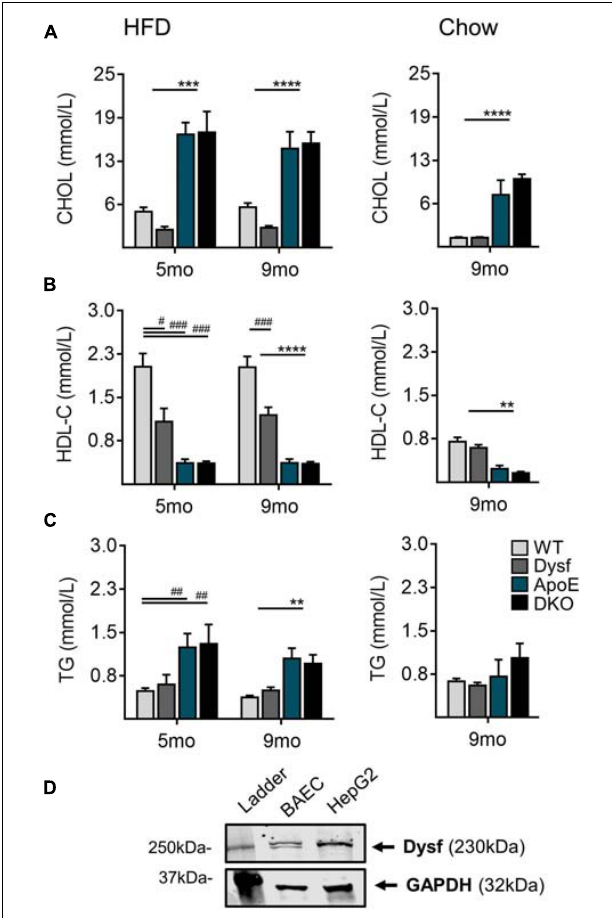
FIGURE 3 | Total plasma cholesterol, high density lipoprotein cholesterol and triglyceride levels in WT, Dysf, ApoE and DKO mice after 5 and 9 months (mo) of HFD-feeding and age-matched chow controls at 9 months. (A) Total cholesterol (CHOL) (B) , high density lipoprotein (HDL-C), and (C) , Triglycerides (TG). (D) Protein extracts from dysferlin-expressing BAEC (control cell lysate), and a its expression in a human hepatocyte derived cell line (HepG2). GAPDH is used as a loading control. 5 months HFD: WT ( N = 10), Dysf ( N = 5), ApoE ( N = 7), DKO ( N = 5), 9 months HFD: WT ( N = 13), Dysf ( N = 14), ApoE ( N = 11), and DKO ( N = 11). WT and Dysf genotypes significantly different from ApoE and DKO; P < 0.01 (**); P < 0.001 (***); P < 0.0001 (****); Significantly different from WT; P < 0.05 ( # ); P < 0.01 ( ## ); P < 0.001 ( ### ); two way ANOVA with Sidak’s post hoc tests, 9 months Chow: WT ( N = 8), Dysf ( N = 11), ApoE ( N = 4), AND DKO ( N = 7). WT and Dysf genotypes significantly different from ApoE and DKO; P < 0.01 (**); P < 0.0001 (****); One way ANOVA Tukey’s post hoc tests. Mean +